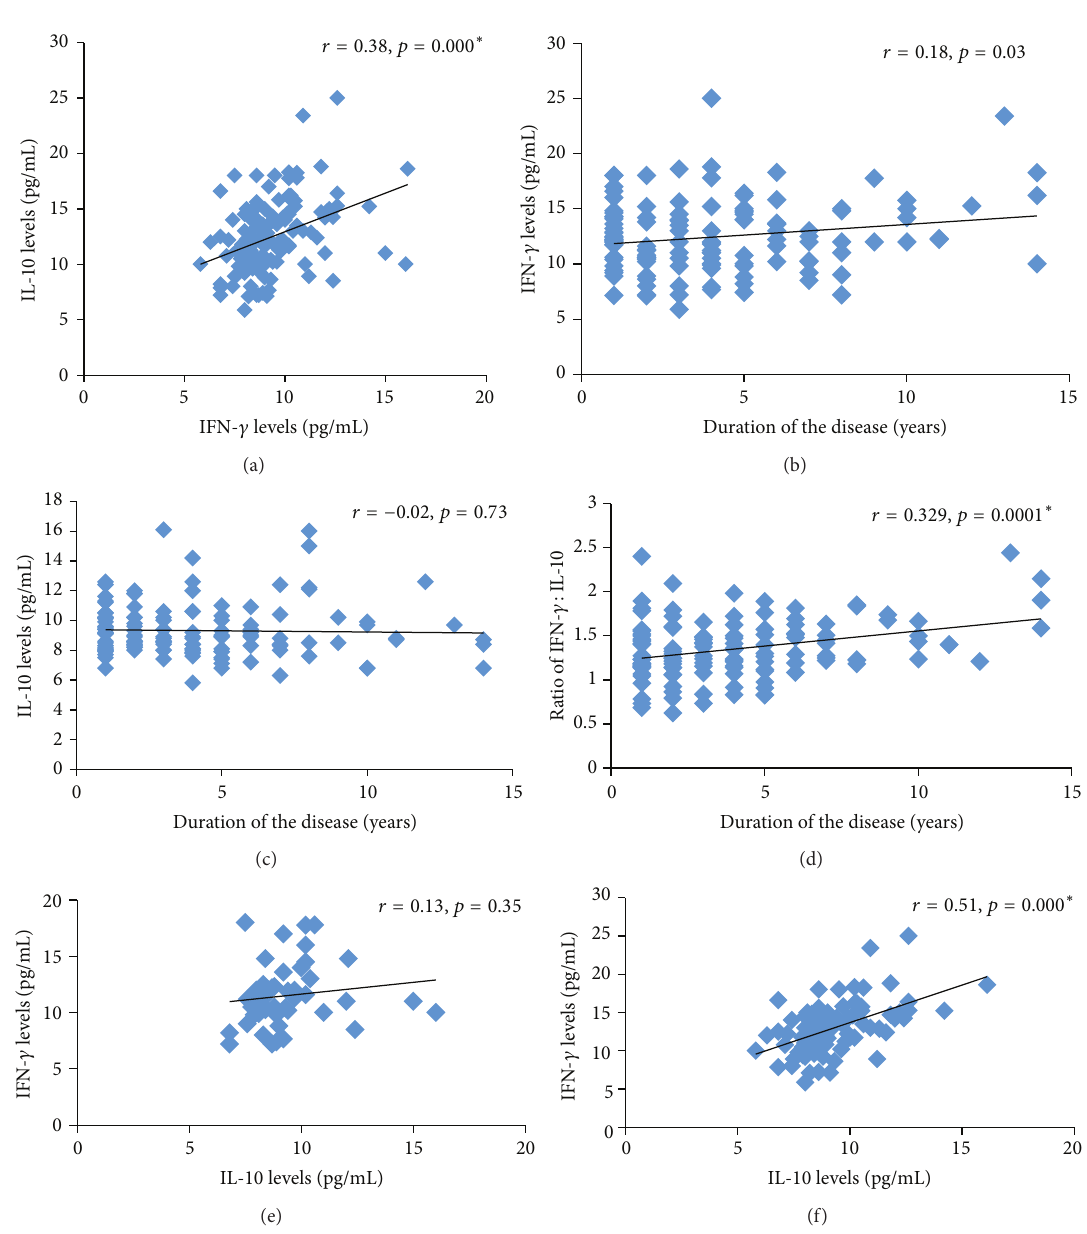
Figure 2: Representing correlation of (a) IL-10 and IFN- 𝛾 levels in patients, (b) duration of the disease with IFN- 𝛾 levels, (c) duration of the disease with IL-10 levels, (d) duration of the disease with IFN- 𝛾 : IL-10 ratio, (e) IL-10 with IFN- 𝛾 levels in stable vitiligo patients, and (f) IL-10 with IFN- 𝛾 levels in active vitiligo